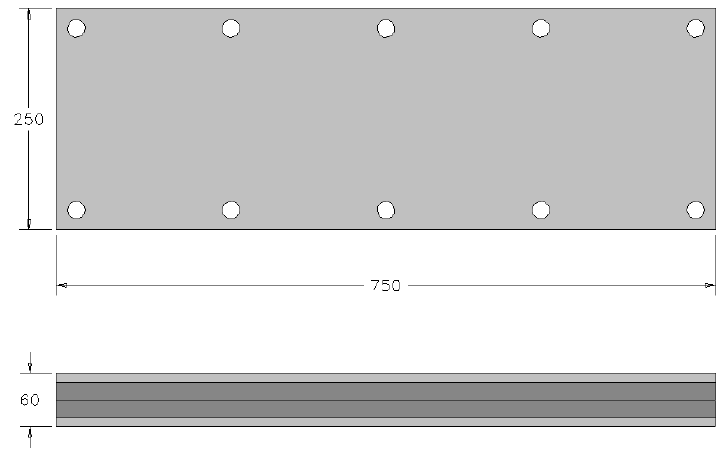
Figure 4. Main dimensions of the mould (in mm).